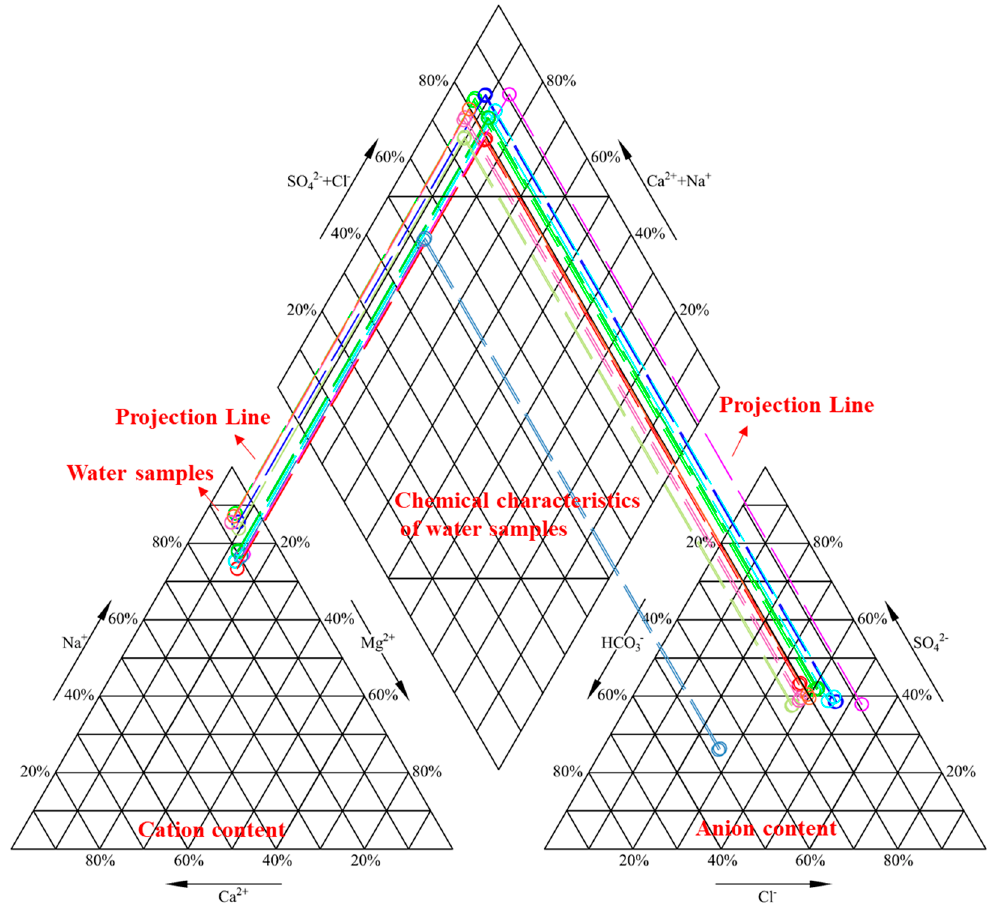
Figure 2. Piper diagram of groundwater samples from Lingxin mine.